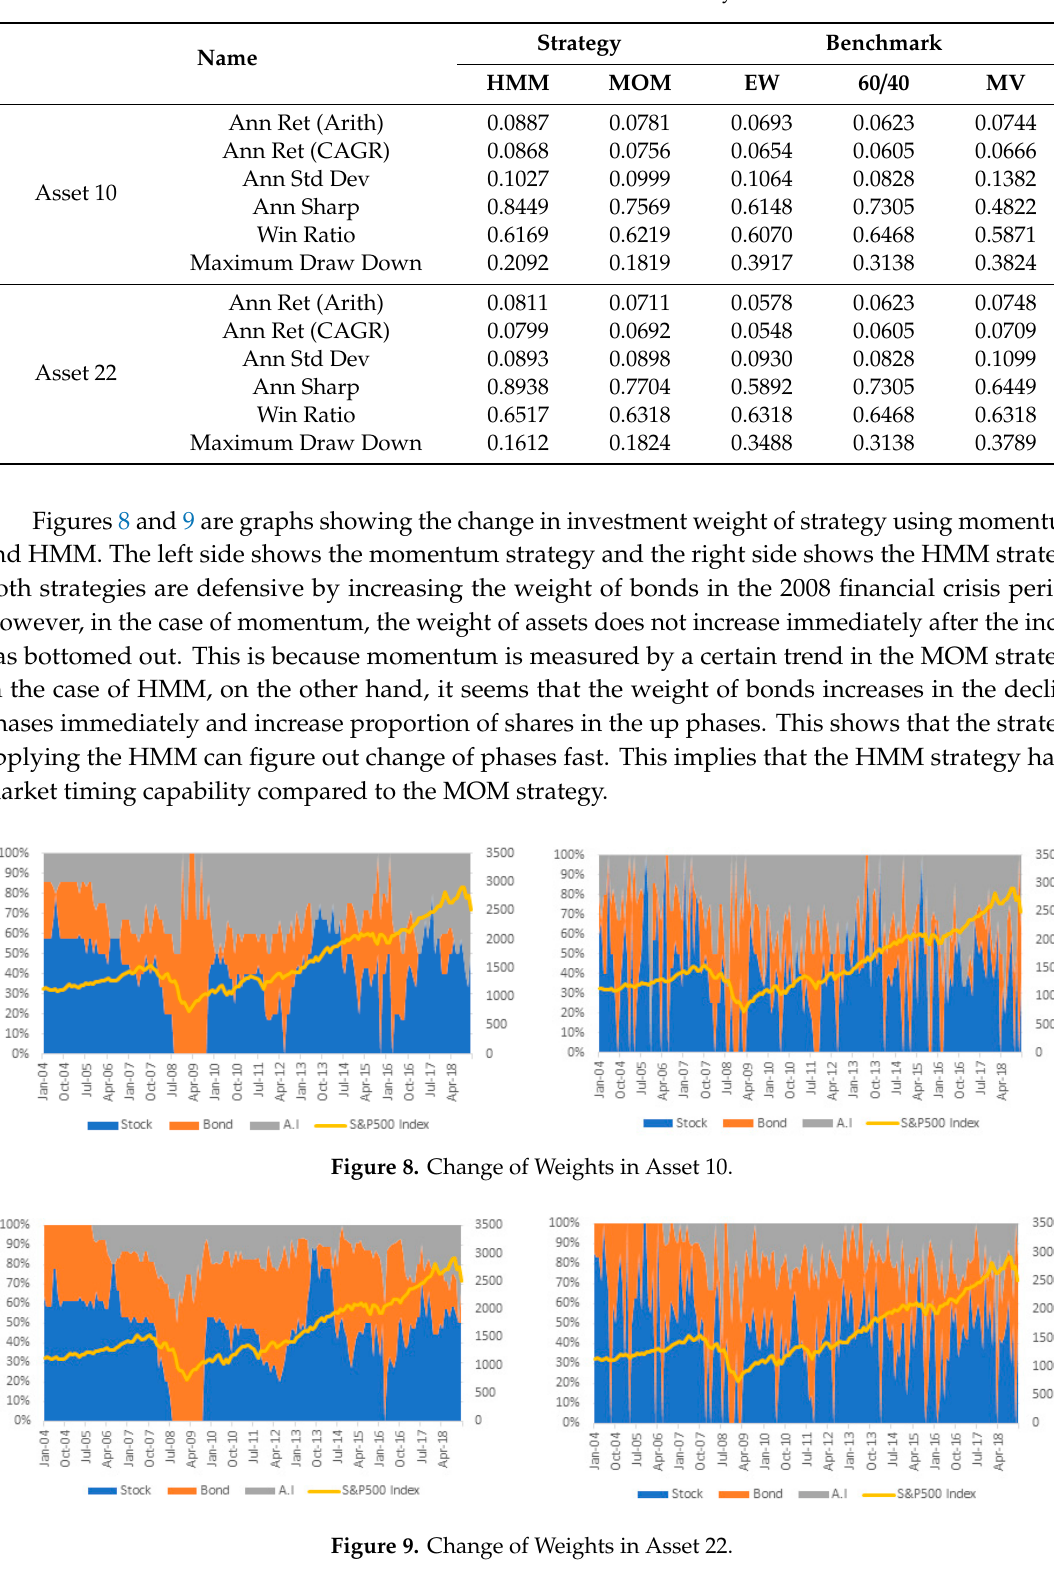
Table 4 . Portfolio Performance Summary.